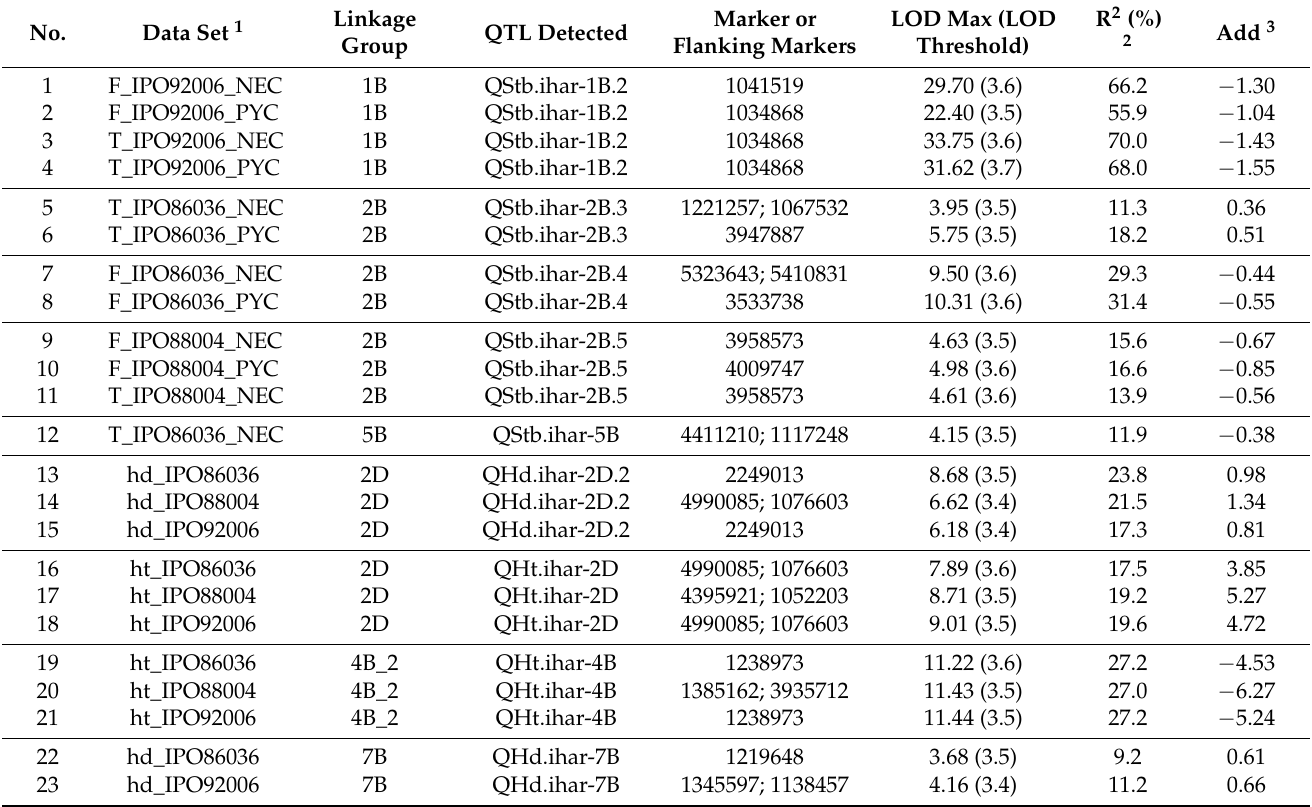
Table 4. Detected QTL for STB resistance, plant height and heading date in Mandub × Begra DH mapping population.